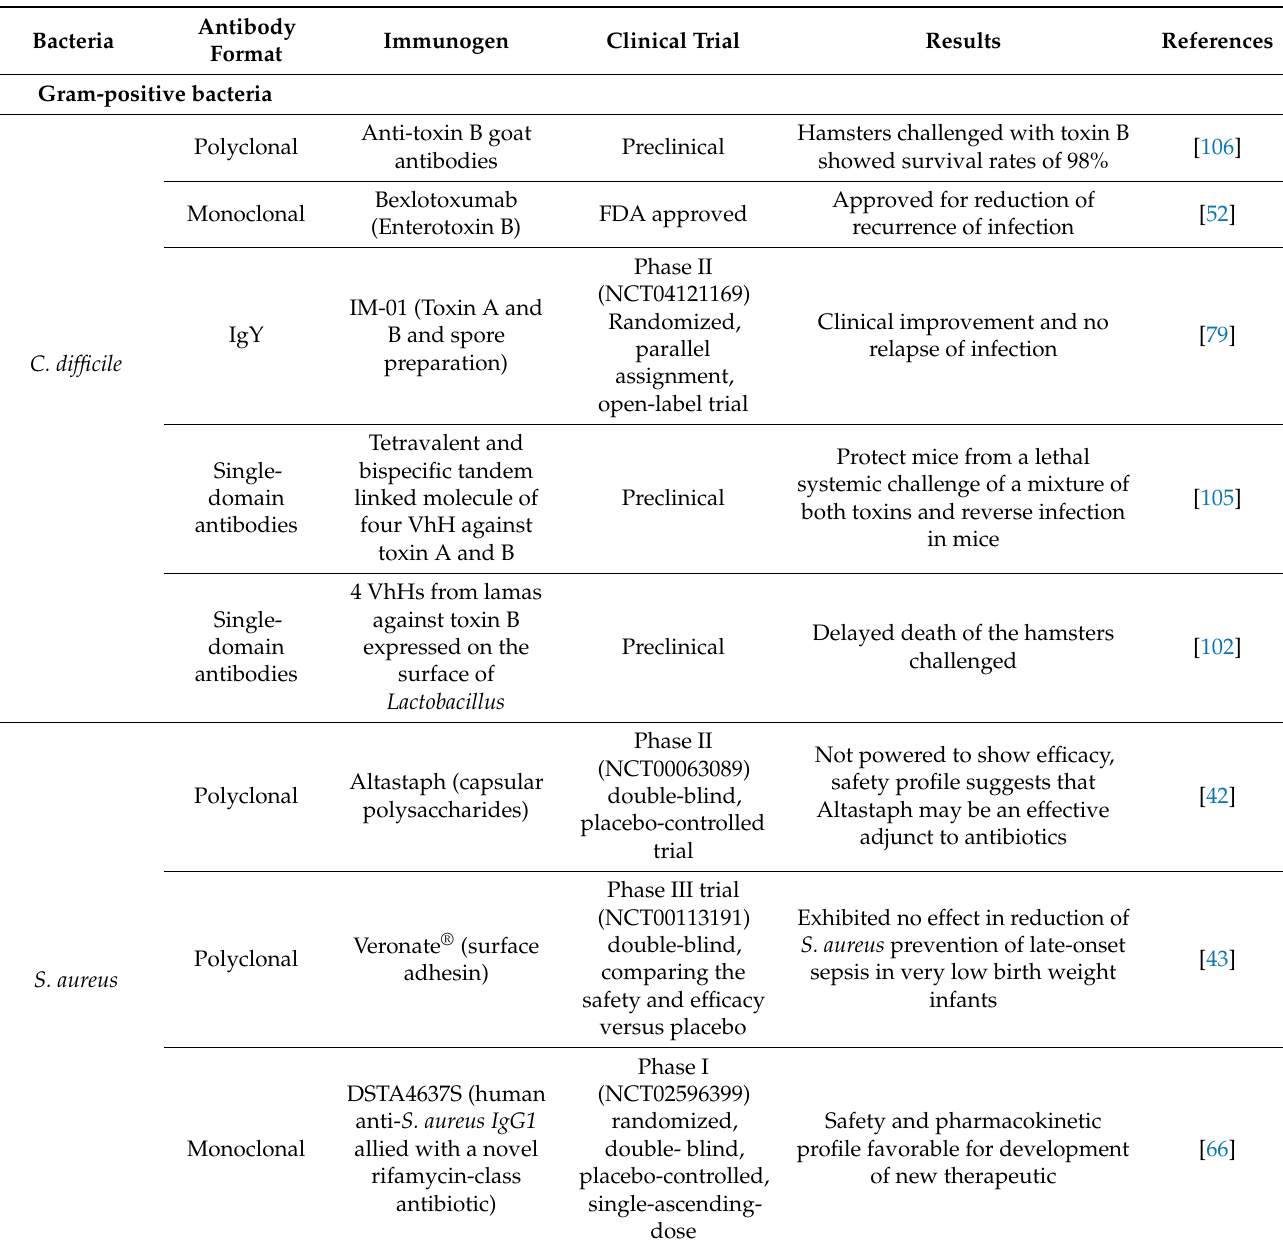
Table 1. Passive immunization preclinical and clinical trials mentioned in the